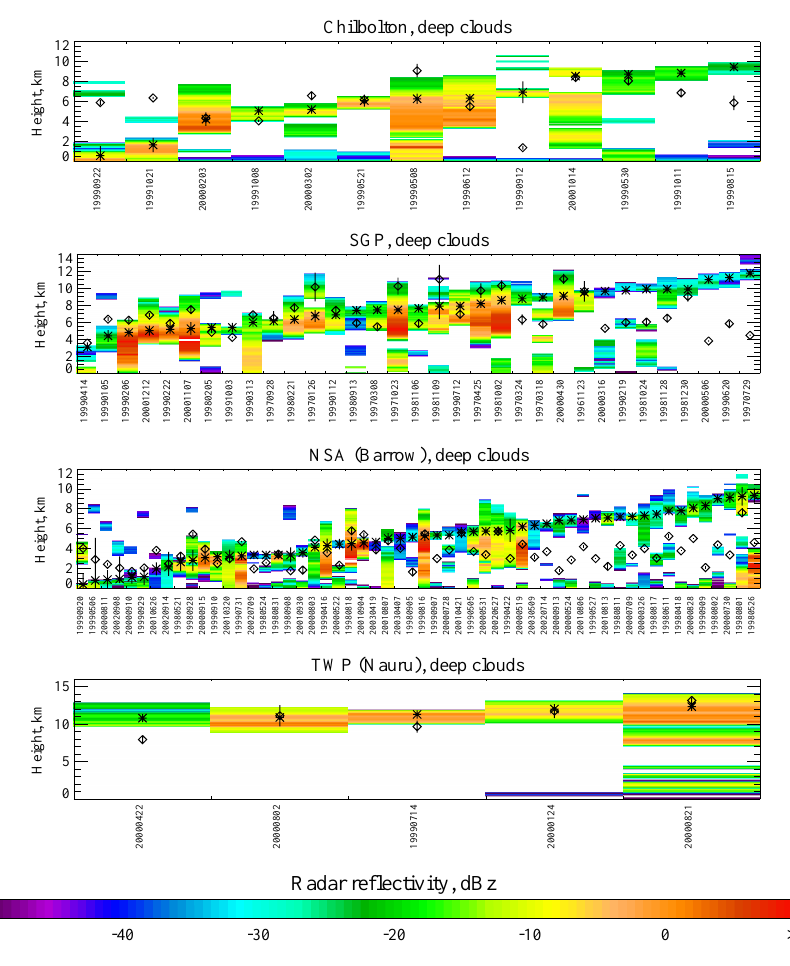
Fig. 10. As Fig. 9, except for deep cloud fields. From top to bottom, the sites are Chilbolton, SGP, NSA and TWP. Table 4. Statistics of CTH comparison for shallow clouds. RMS indicates the root-mean square difference, and r Pearson’s correlation coefficient. Site Number of RMS Mean CTH, km Standard deviation, km